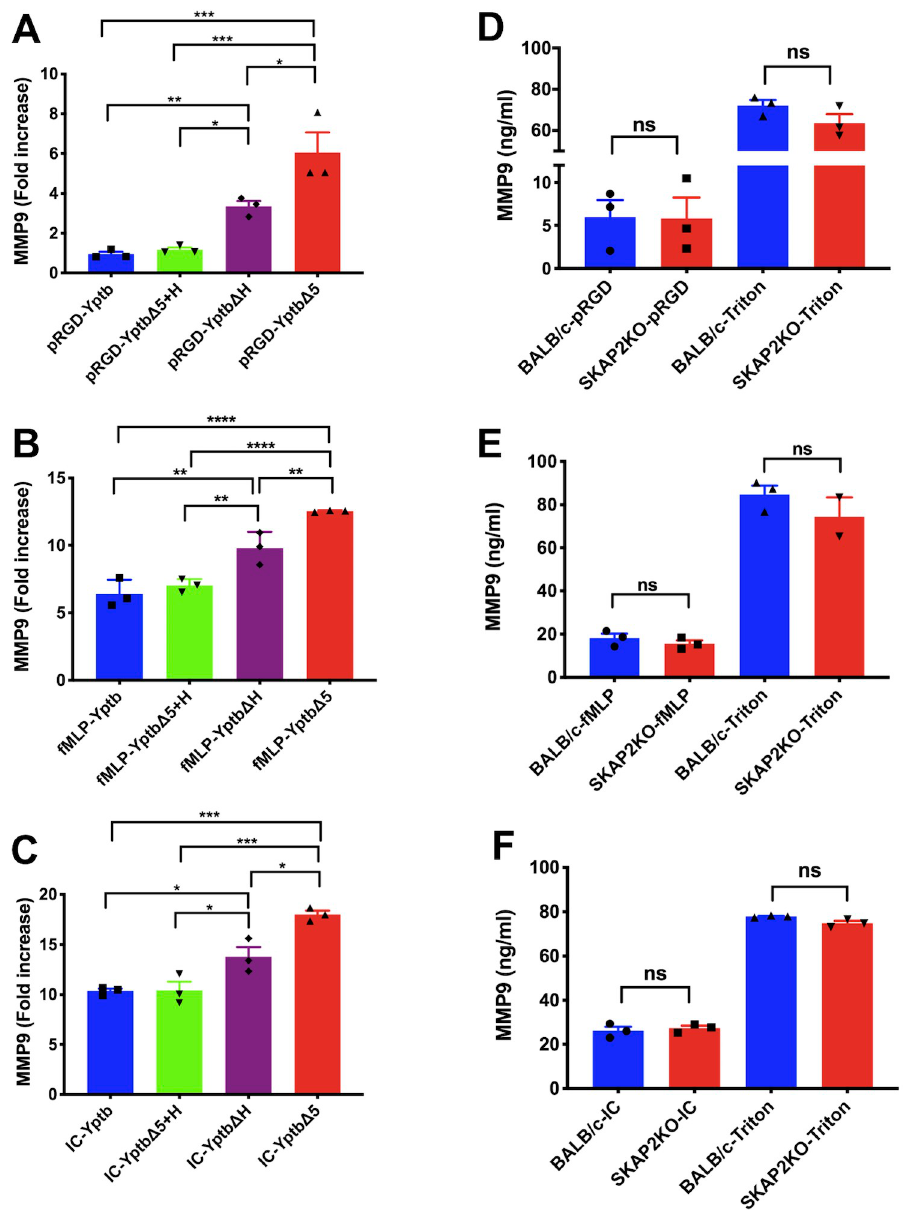
Fig 6. YopH reduces tertiary granule release, while SKAP2 is dispensable for tertiary granule release in neutrophils. Tertiary degranulation of (A-C) WT BM neutrophils that were simultaneously infected with WT- Yptb , Yptb- Δ 5 +pBAD, Yptb- Δ 5 +pYopH or Yptb- Δ yopH at a MOI of 20:1 or of (D-F) WT and Skap2KO BM neutrophils stimulated for 3 hrs by (A, D) plating on poly-RGD, (B, E) priming with LPS for 20 minutes and treating with 1 μ M fMLP, or (C, F) plating on IC. Cell free supernatants were analyzed for MMP-9 by ELISA with background subtraction of the unstimulated controls (FBS-plated controls). (A-C) Data for infections are expressed as fold increase relative to uninfected, unstimulated control samples from FBS coated plates. (D-F) Amount of MMP-9 (ng/ml) for WT and Skap2KO BM neutrophils with background subtraction of the unstimulated (FBS-plated) controls are reported. Triton X-100-treated wells were used to determine the total granule content of WT and Skap2KO BM neutrophils. The data represent the means ± SEM from 3 independent experiments done in 2–3 replicates. Statistical significance was calculated using (A-C) one-way ANOVA followed by Tukey’s Post-test or (D-F) Student t-test.